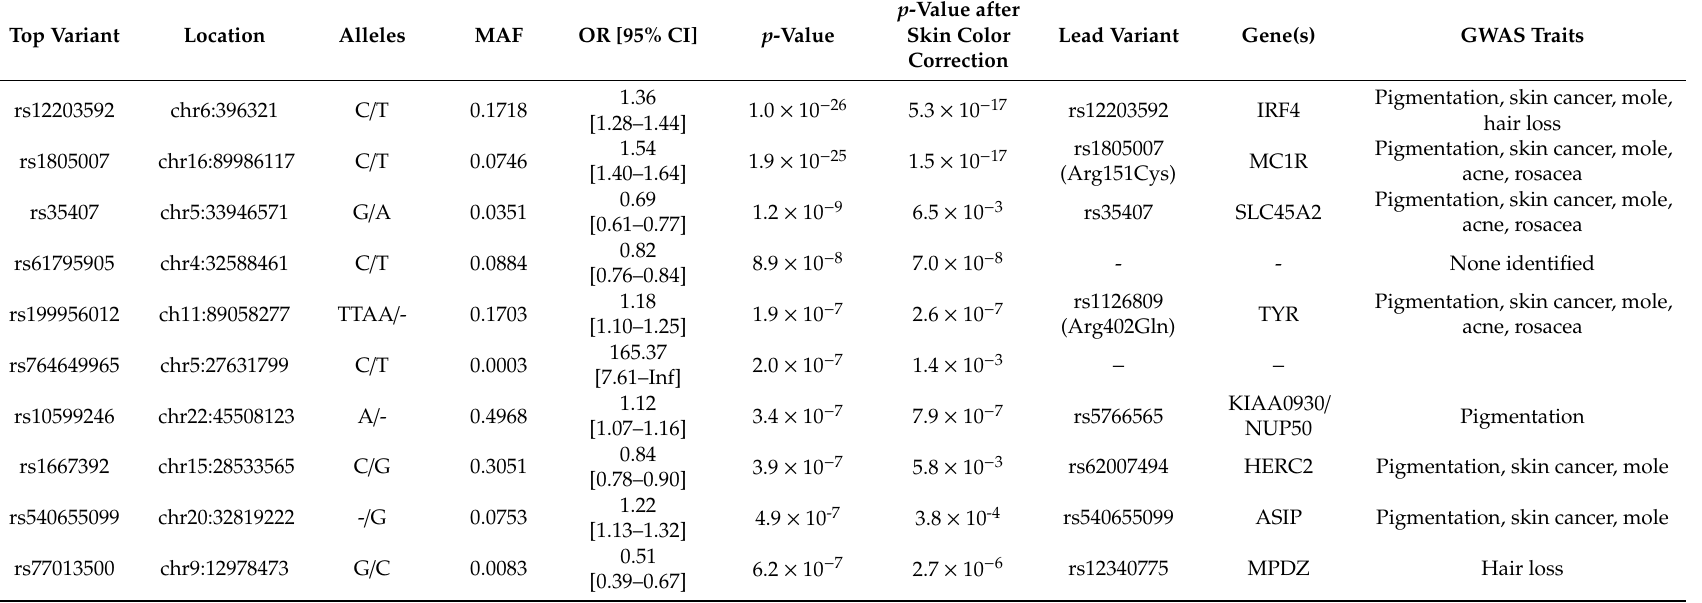
Table 2. Top variant association results from the sensitive skin GWAS, association p -values after skin color correction, and known associations for these loci (lead variant, gene(s) and associated GWAS traits